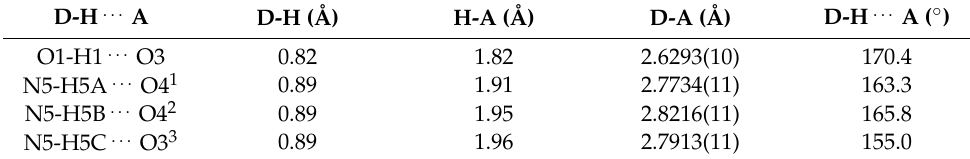
Table 3. Geometrical parameters of the hydrogen bonding interaction in the IBP–TXA salt.